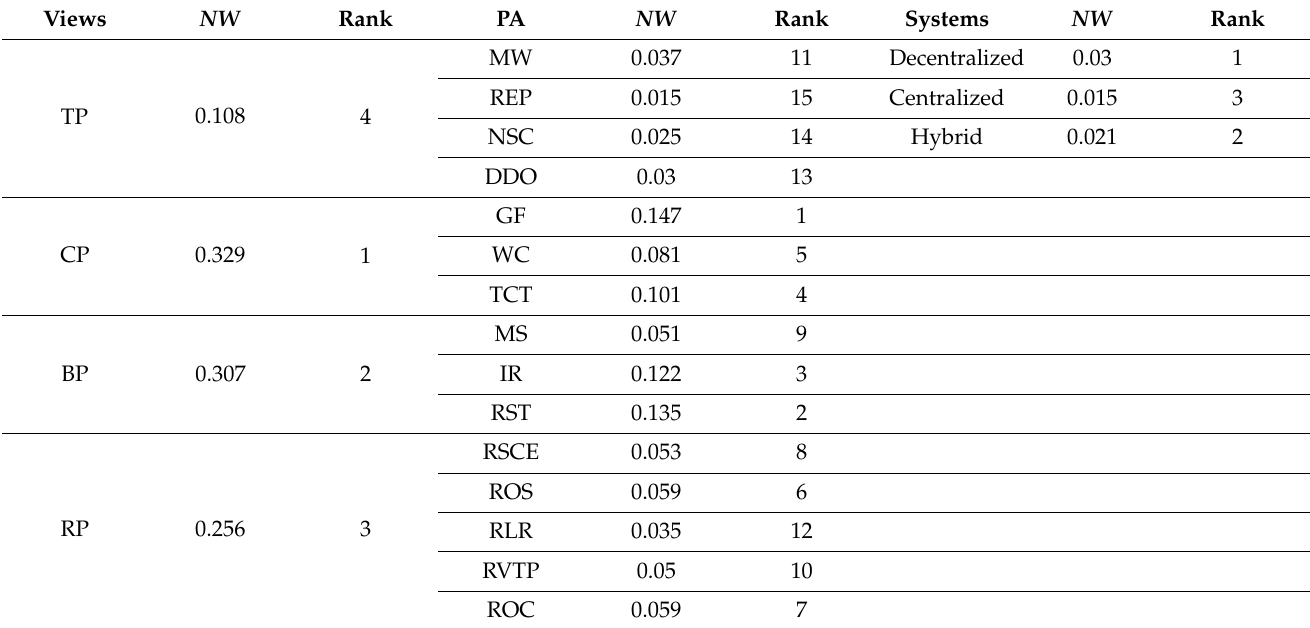
Table 14. The synthesis results of fuzzy-BWM